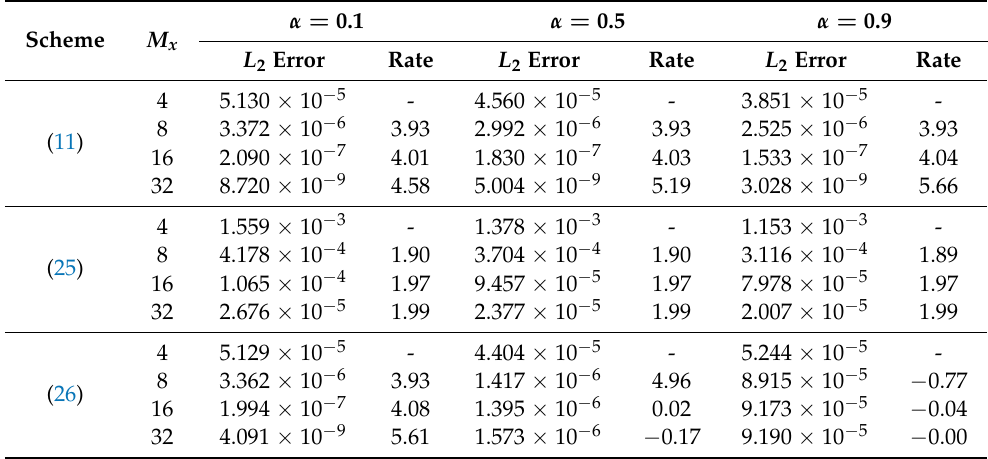
Table 2. The L 2 -norm errors in space for smooth case in Example 1 with τ = T /8192, ϑ = 2.5, κ = 0, r = 0.06, D = 0, and σ = 0.1.